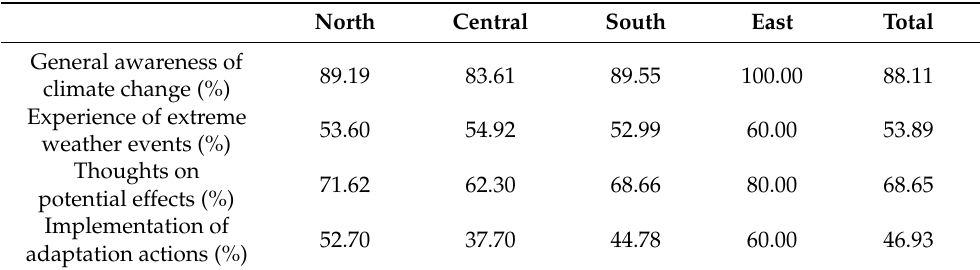
Table 9. Differences in the awareness and experience of climate change and adaptation actions of respondents from the north, central, south and east